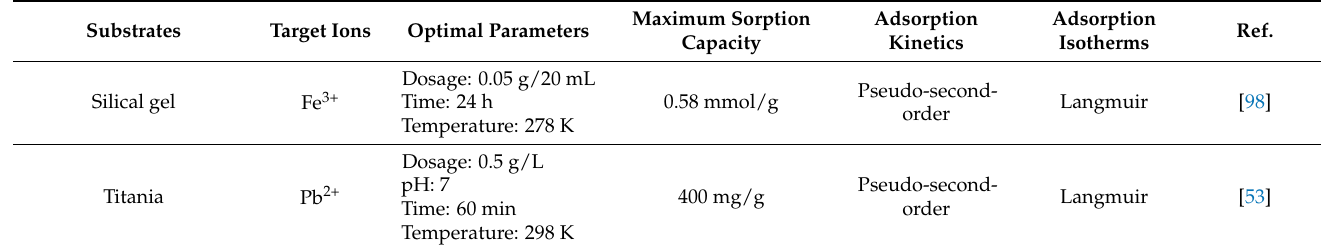
Table 2. Adsorption of heavy metal ions by different PAMAM functionalized nanomaterials.